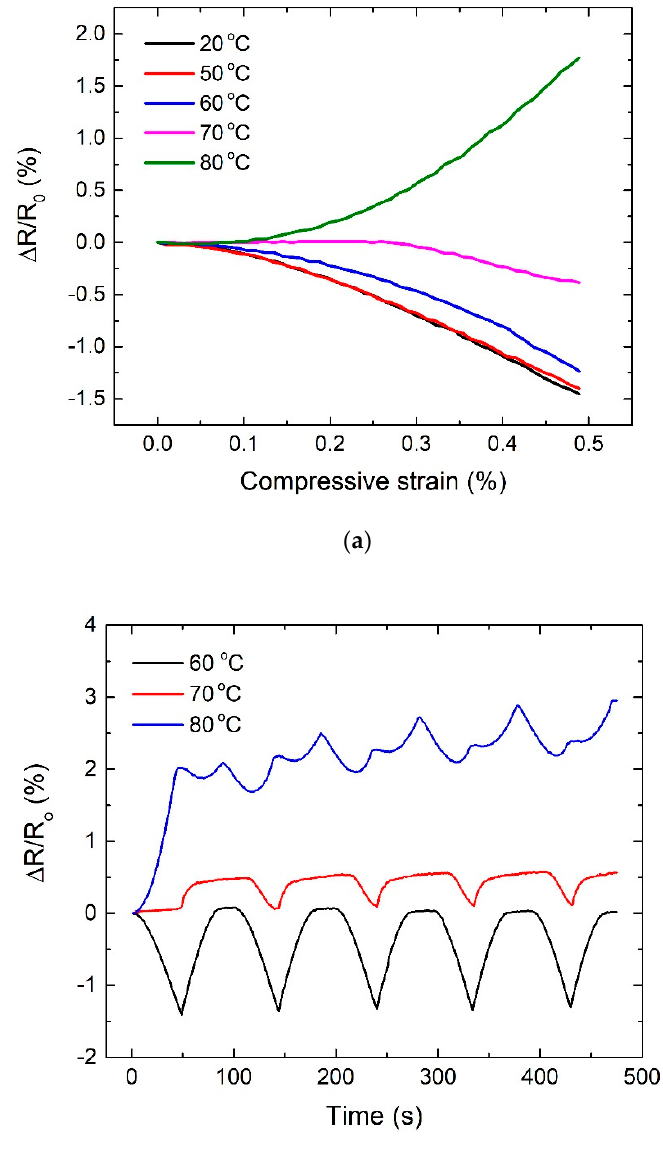
Figure 6. Electro-mechanical behavior of CNT / epoxy composites (1.0 wt %) under ( a ) static compressive loading and ( b ) cyclic compressive loading.